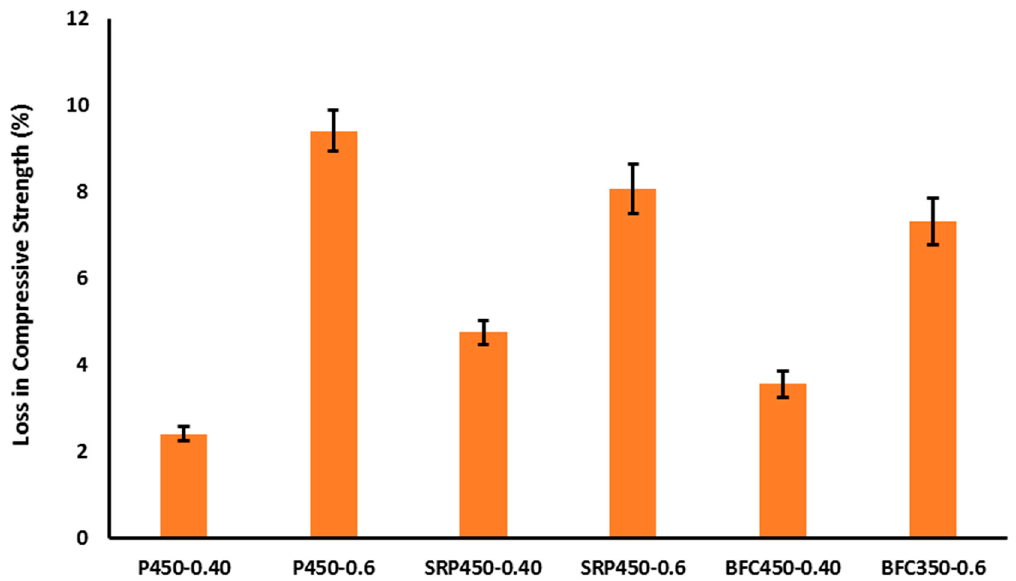
Figure 6. Strength loss of “high strength concrete” class after sulfate exposure.